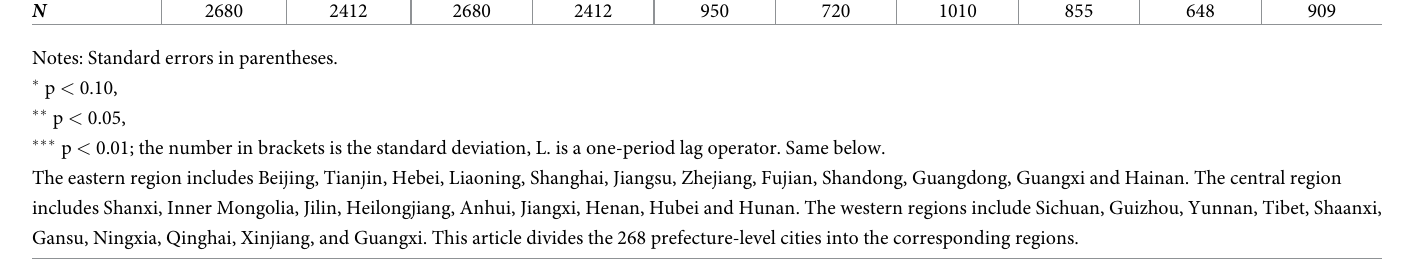
Table 4. Haze pollution and insurance development: Analysis of residents’ participation in the insurance. Insurance density and premium income